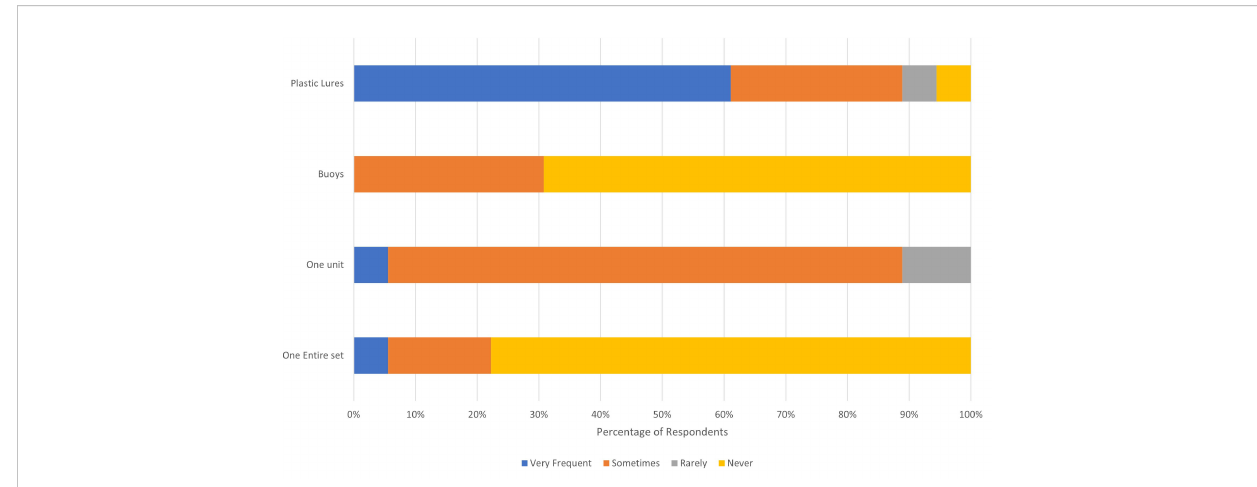
FIGURE 11 Summary of interview results from Dominica to the question: “ When or if fi shing gear with hooks and lines or parts thereof are lost which of the following elements are lost and at what frequency? ” . (n=18).